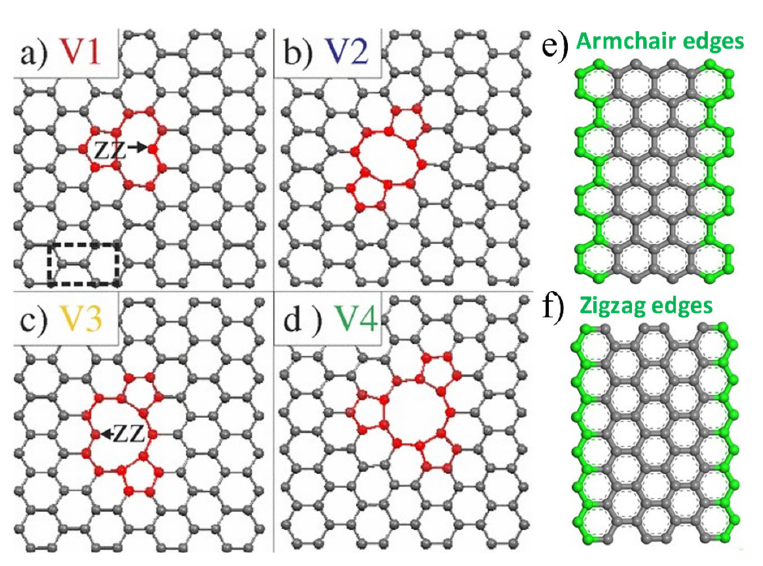
Figure 2. Scheme of ( a – d ) different topological defects (Reprinted with permission from reference [44]); ( e ) armchair edges, and ( f ) zigzag edges in graphene.